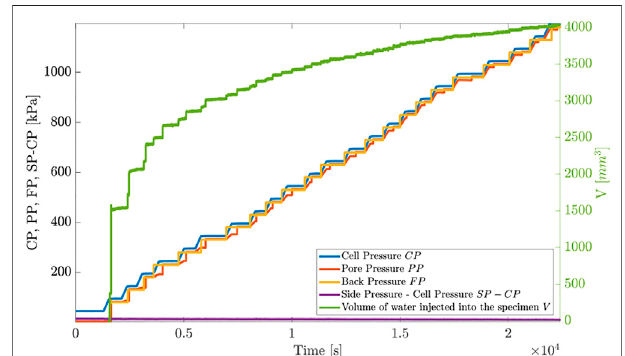
FIGURE 3 | Cell pressure, pore pressure, back pressure, and the difference between side and cell pressures on the left axis, and volume of water injected into the specimen on the right axis versus time, during Skempton phase.